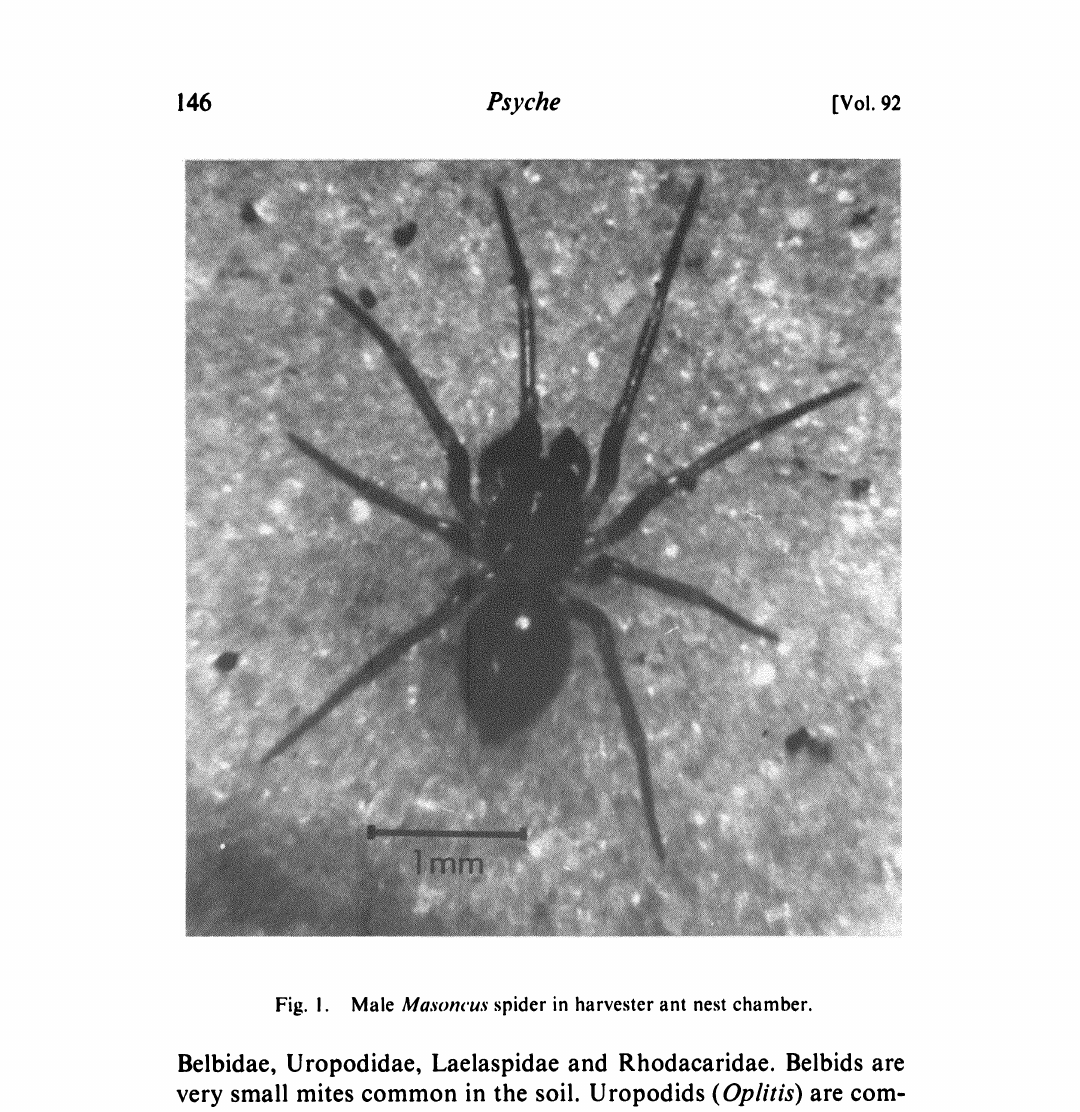
Fig. I. Male Masom’us spider in harvester ant nest